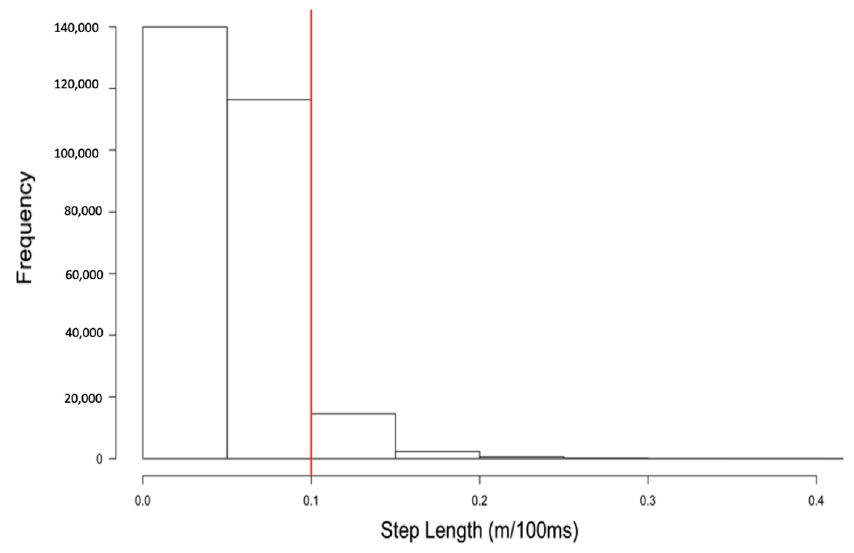
Figure 4. Step lengths during all ray tracks. The red line indicates a drop-off in frequency at a step length of 0.1 m/100 ms.